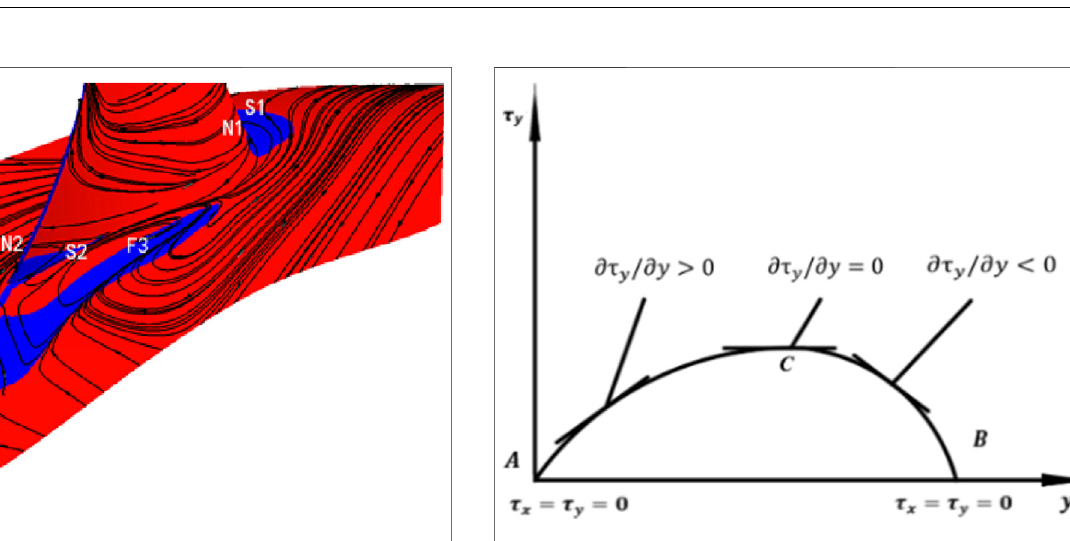
FIGURE 6 | Nonlinear solutions and singularity combinations when (A) Δ > 0 , b 2 > 0, (B) Δ > 0 , b 2 < 0, and (C) Δ < 0 , b 2 > 0.